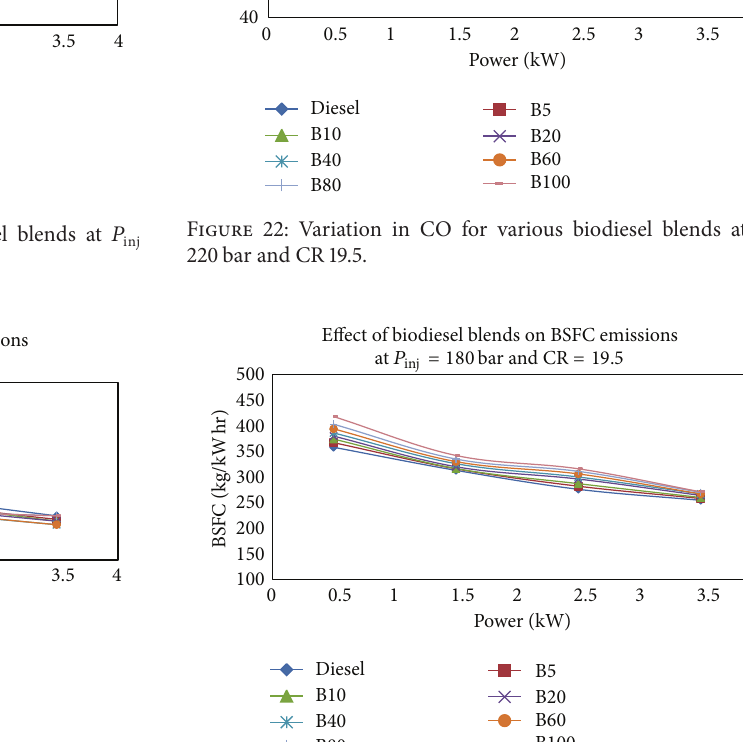
inj Figure 23: Variation in BSFC for various biodiesel blends at 𝑃 180 bar and CR